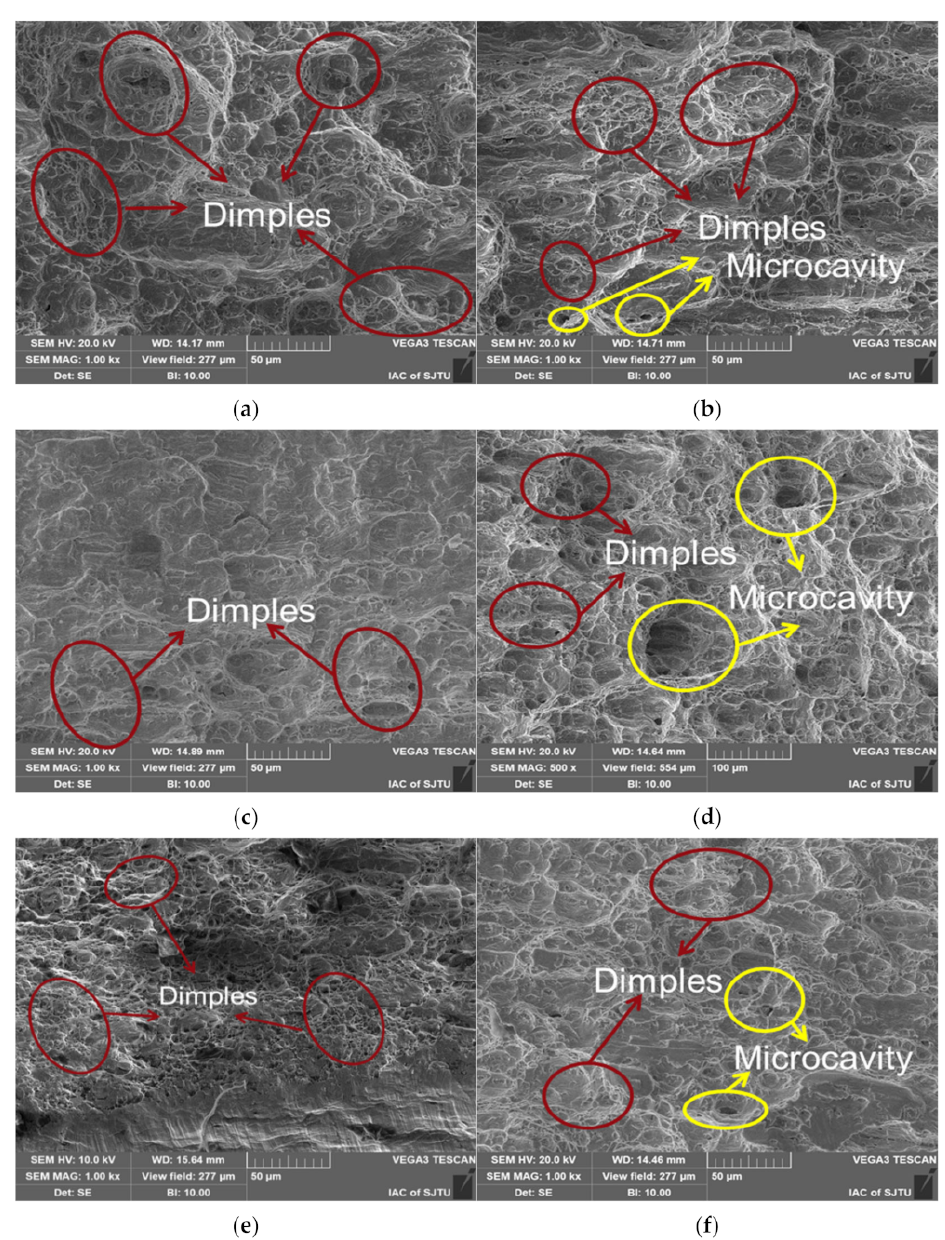
Figure 14. SEM micrographs revealing typical structure in ultimate fracture zone for specimens with LSP (( a ) 1.2% strain amplitude, ( c ) 0.8% strain amplitude, ( e ) 0.4% strain amplitude) and specimens without LSP (( b ) 1.2% strain amplitude, ( d ) 0.8% strain amplitude, ( f ) 0.4% strain